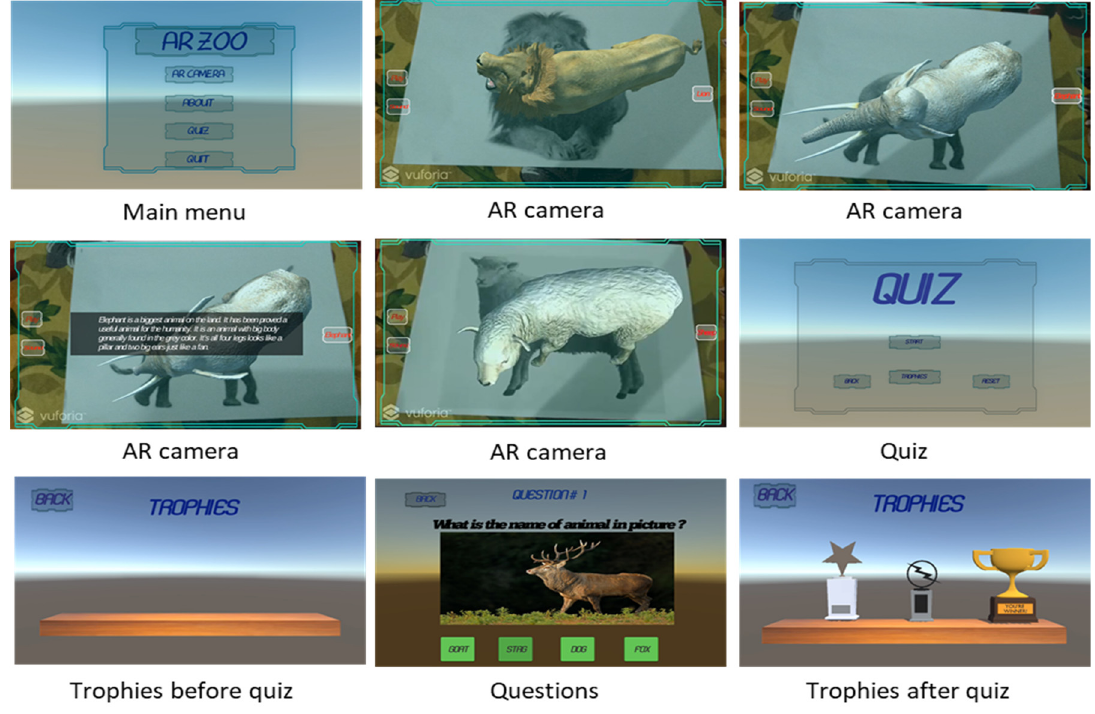
Figure 7. Images of different AR camera scenes and quiz performances from the application “AR